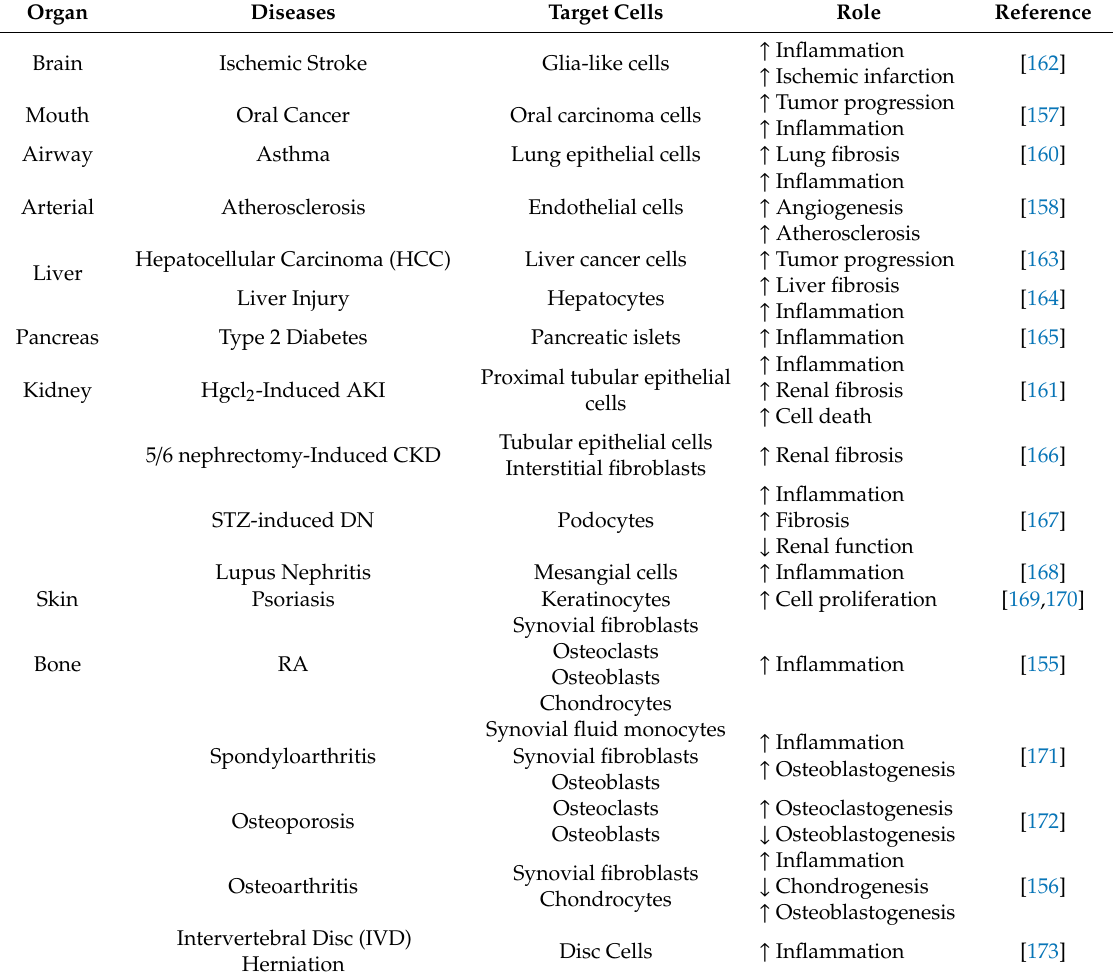
Table 1. IL-20: biological e ff ects and target